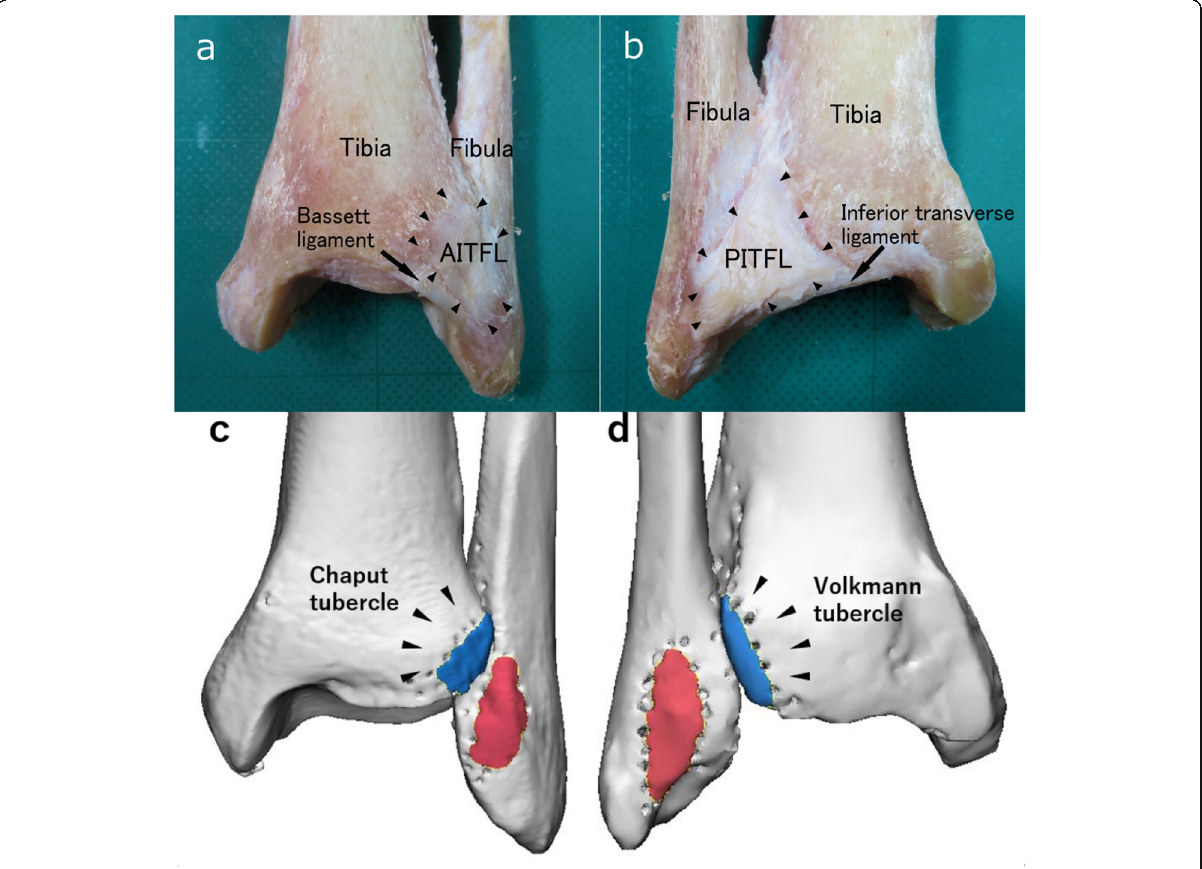
Fig. 2 Specimen photographs and three-dimensional computed tomography images of the ankle. a Anterior and ( b ) posterior photographs. c Anterior and ( d ) posterior views of the three-dimensional computed tomography images. AITFL = anterior inferior tibiofibular ligament; PITFL = posterior inferior tibiofibular